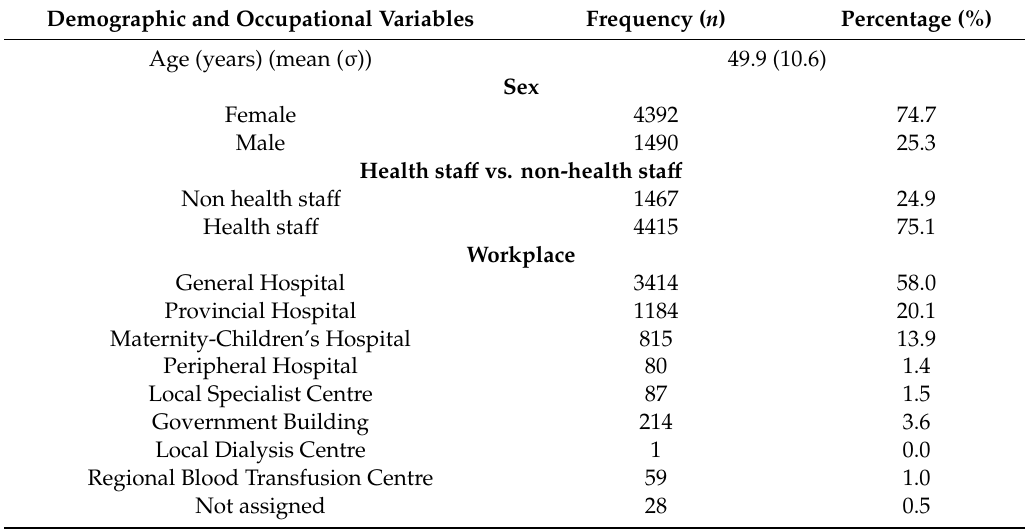
Table 1. Distribution of the population according to sex, professional category and workplace ( n =